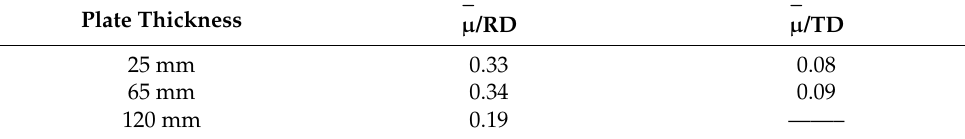
Table 4. The value of